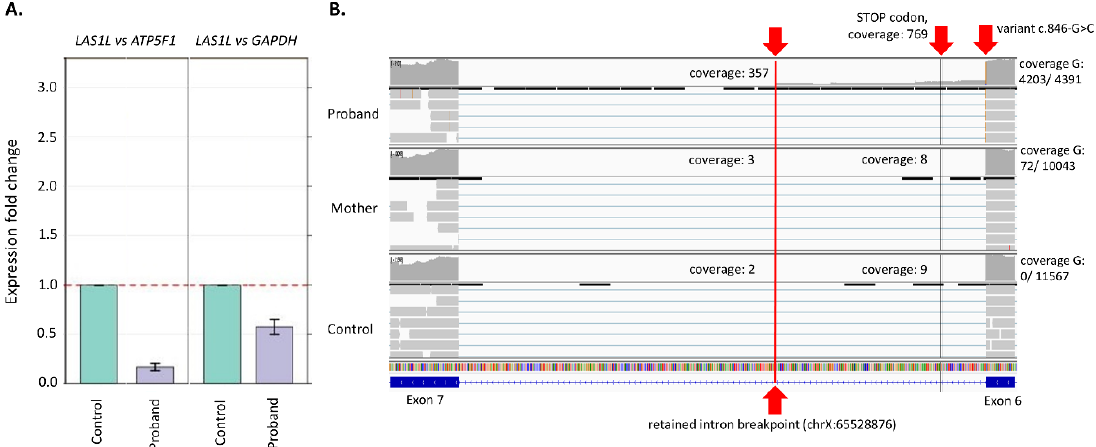
Figure 2. ( A ) Results from real-time PCR. A visible decrease of expression can be seen when the proband is compared to the control ( B ) Results from deep amplicon sequencing of cDNA. A partial retained intron is visible in the proband, while it is not present in the mother and the control. A partial retained intron breakpoint is marked with red line (g.X:65528876, from this position coverage drops significantly). Probably the decrease in the expression of LAS1L is caused by nonsense mediated decay due to the presence of a codon stop after 24 amino acids derived from the intronic se- quence.